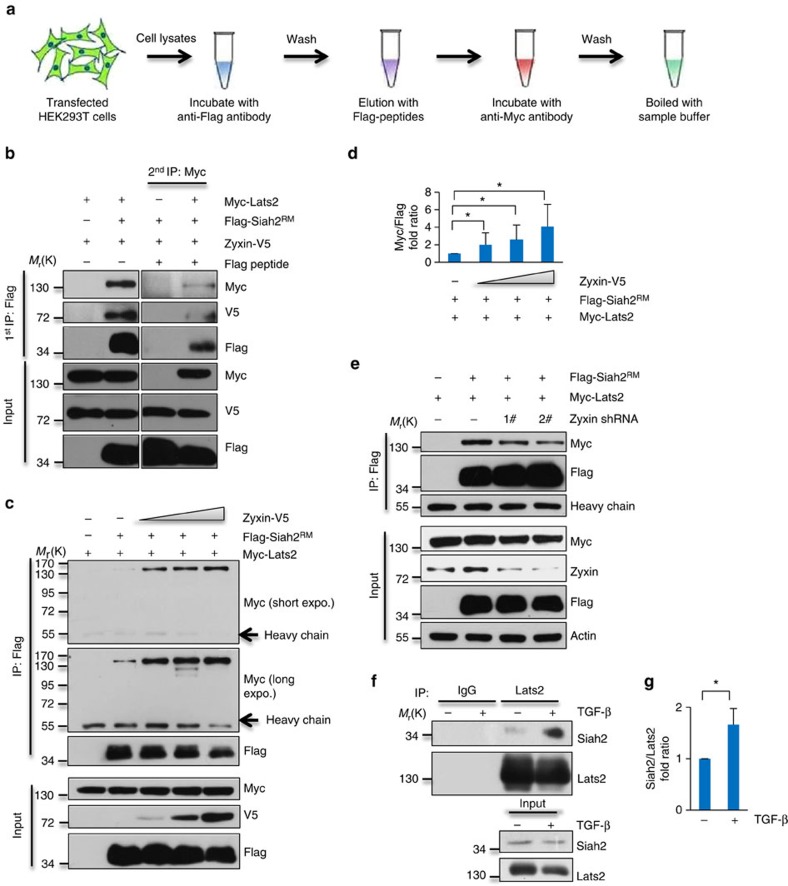
Zyxin forms a ternary complex with Siah2 and Lats2 and enhances Siah2–Lats2 binding.(a,b) Double coimmunoprecipitation was performed as depicted (a) and the interactions were determined by western blotting (b). (c,d) Enhanced interaction between exogenously expressed Myc-Lats2 with Flag-Siah2RM in the presence of increased amount of ectopic expression of Zyxin (c) and quantification of Myc-Lats2 (normalized to Flag-Siah2RM) protein levels (d). Ratio t-test was applied. (e) Weakened interaction between exogenously expressed Myc-Lats2 with Flag-Siah2RM in Zyxin-knockdown HEK293T cells. (f,g) MDA-MB-231 cells were treated with 5 μM MG132 and 5 ng ml−1 TGF-β for 12 h. Endogenous interaction between Lats2 and Siah2 was analysed by coimmunoprecipitation (f) and quantification of Siah2 (normalized to Lats2) protein levels (g). Ratio t-test was applied. All data are mean of n=3 independent experiments. All error bars indicate s.d. *P<0.05.